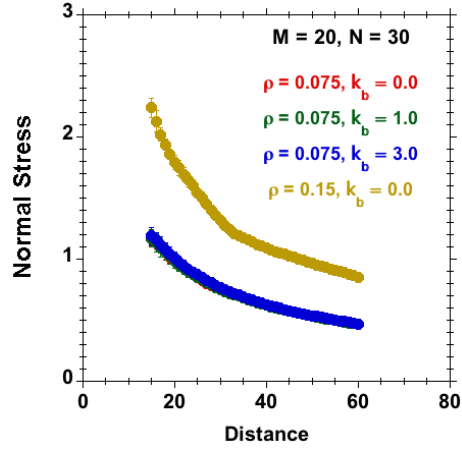
Figure 5. Normal stress versus gap size (system with M = 20, N = 30 subject to good-solvent conditions, constant bead number density) for different bending stiffness and surface densities, k b = 0 (red), k b = 1 (green) and k b = 3 (blue), for a brush system at ρ = 0.075 and k b = 0 (yellow) for a more densely grafted system at ρ = 0.15. The results are from equilibrium MD simulations. The normal stress is basically unaffected by bending stiffness over the shown range of